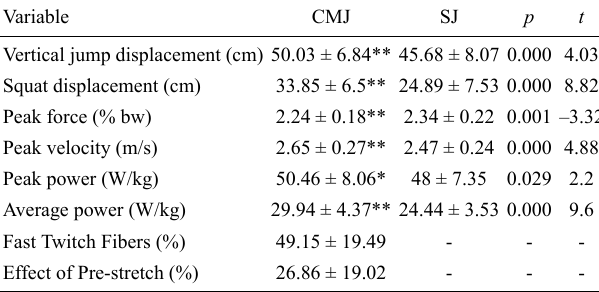
Table 1. Characteristics of performance during the countermovement jump (CMJ) and squat jump (SJ) (n = 96). Variable CMJ